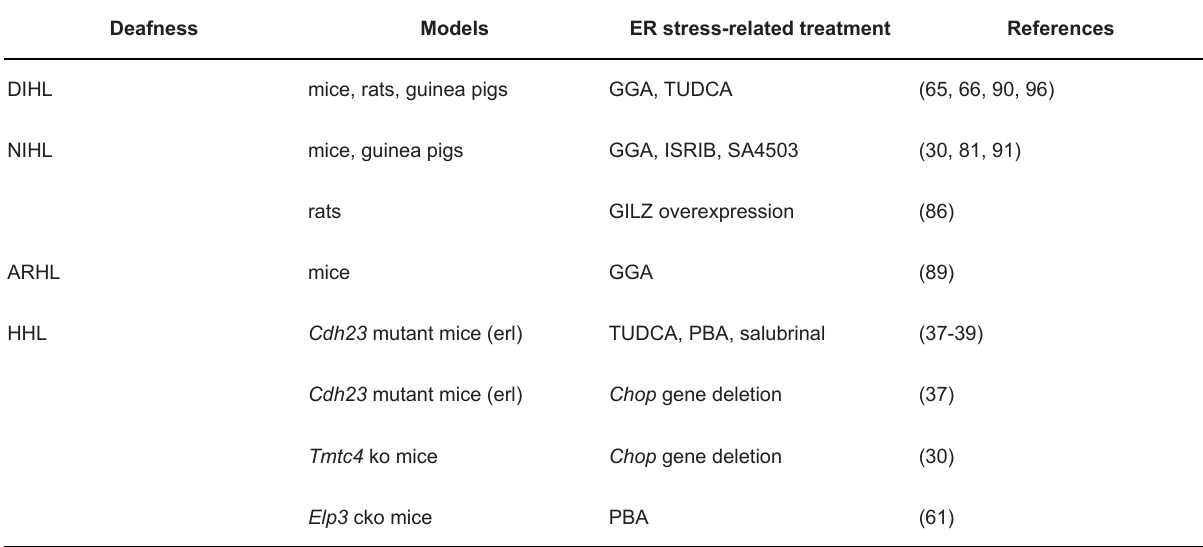
Table 1. Potential ER stress-base treatment of